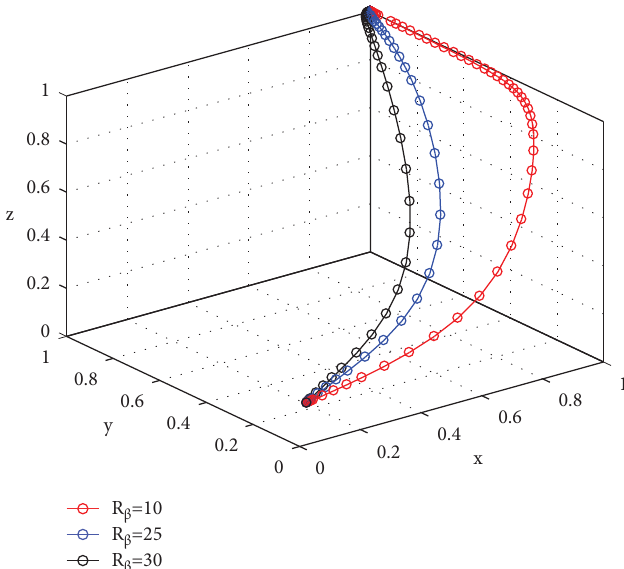
Figure 4: Efect of costs on evolution results. (a) Costs incurred by mariculturists adopting the ecological aquaculture mode; (b) costs ( C incurred by aquatic enterprises in investing in the ecological aquaculture mode.